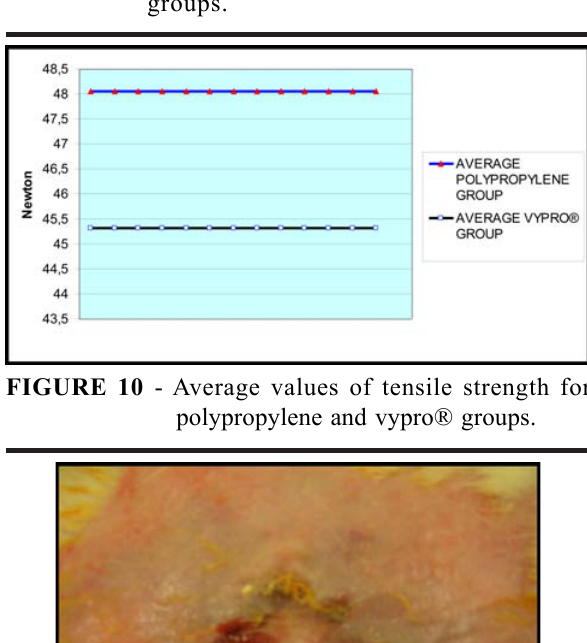
FIGURE 9 - Result of traction test comparing the tensile strength of the polypropylene and vypro® groups.